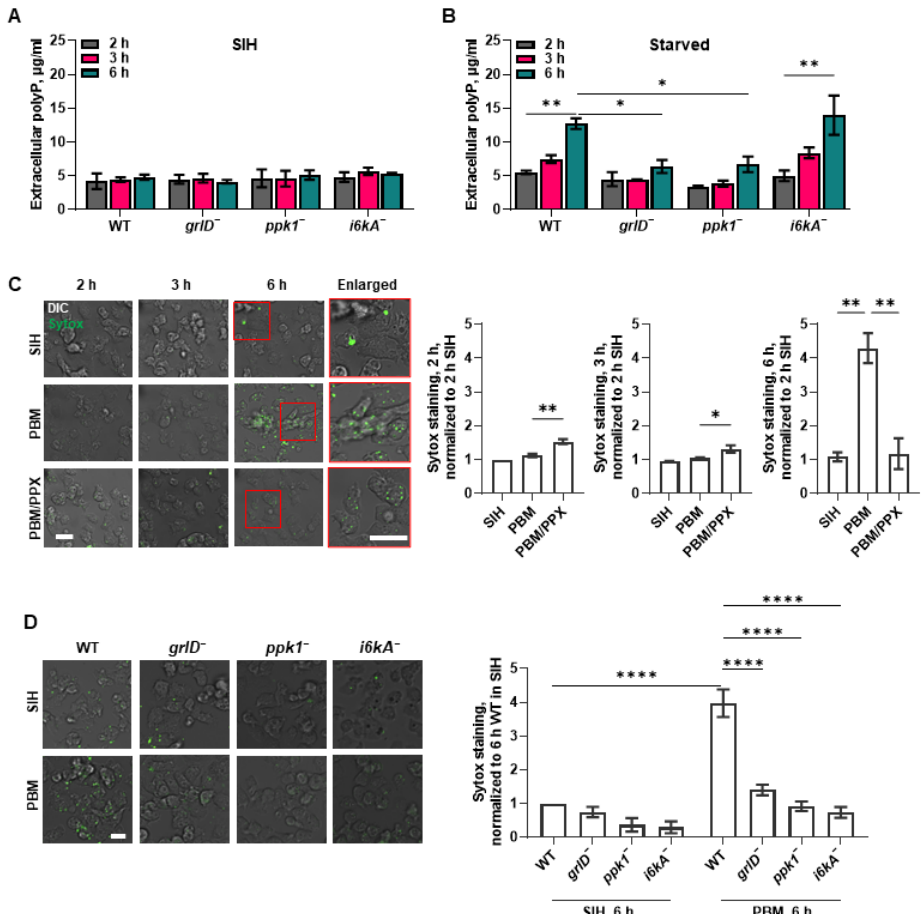
Figure 1. Starving D. discoideum cells require GrlD and Ppk1 to accumulate extracellular polyP, and GrlD, Ppk1, and I6kA to accumulate cell surface polyP. ( A , B ) Wild-type (WT), grlD − , ppk1 − , and i6kA − cells were incubated in SIH ( A ) or starved in PBM ( B ) for 2, 3, and 6 h and extracellular polyP concentrations were measured at the indicated times. ( C ) WT cells were incubated in SIH, PBM, or PBM with PPX for 2, 3, and 6 h, stained with SYTOX (green), and the mean fluorescence intensities of SYTOX staining were measured at the indicated times. The mean fluorescence intensity of SYTOX staining in cells incubated in SIH for 2 h was considered 1. Representative images of 3 independent experiments are shown. Cell boundaries in the enlarged insets show the SYTOX staining (green) of cells. DIC indicates differential interference contrast. Bars are 10 μ m. ( D ) WT, grlD − , ppk1 − , and i6kA − cells were incubated in SIH or PBM for 6 h, stained with SYTOX, and the mean fluorescence intensities of SYTOX staining were measured. The mean fluorescence intensity of SYTOX staining in cells incubated in SIH for 6 h was considered